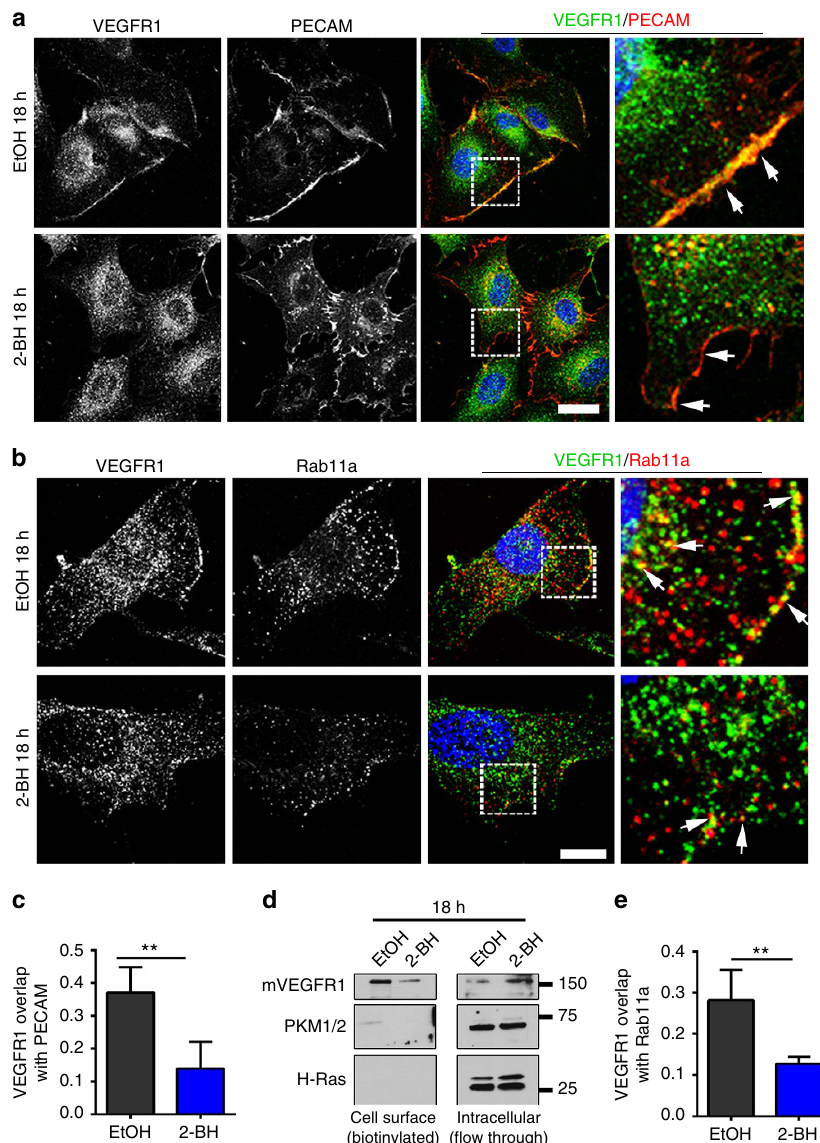
Figure 3 | Palmitoylation regulates VEGFR1 trafficking. ( a , b ) ( a ) Immunofluorescence of VEGFR1 and PECAM or ( b ) VEGFR1 and Rab11a in HUVEC with indicated treatments; 2-BH, 2-bromohexadecadnoic acid, scale bars: 20 and 10 m m for a , b , respectively. ( c , e ) Mander’s Correlation Coefficient quantification of overlap of VEGFR1 and PECAM ( c ) or Rab11a ( e ) in HUVEC treated as indicated. (No. of cells: VEGFR1/PECAM: EtOH, n ¼ 14; 2-BH, n ¼ 12; VEGFR1/Rab11: EtOH, n ¼ 23; 2-BH, n ¼ 27); three replicates. ( d ) Immunoblot of cell surface or intracellular VEGFR1 from HUVEC with indicated treatments. PKM1/2, cytoplasmic marker; H-Ras, specificity control. Statistics: Shown are means þ 95% CI. Student’s t -test with post-hoc Tukey’s range test. ** P r